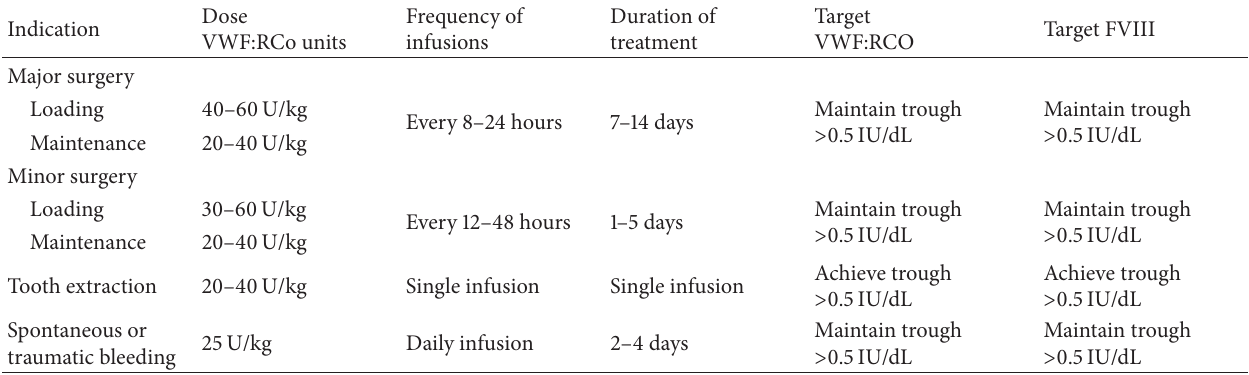
Table 3: Recommended factor VWF/FVIII concentrates dosages for different indications in the treatment of VWD3 [24–26].